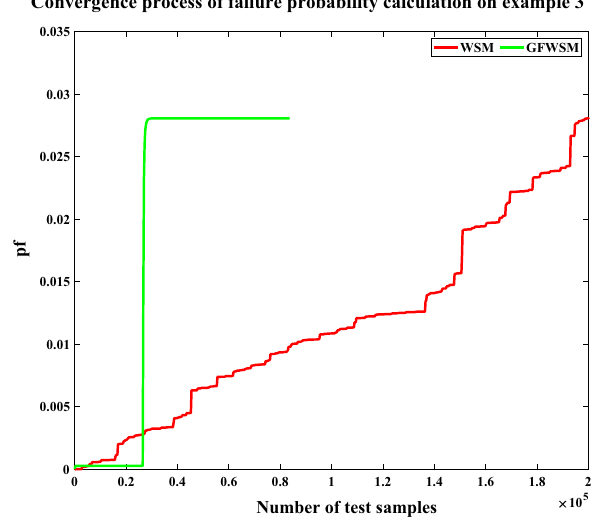
Fig. 6 Simulation results on reliability analysis example 3: conver- gence process of failure probability of WSM and GFWSM